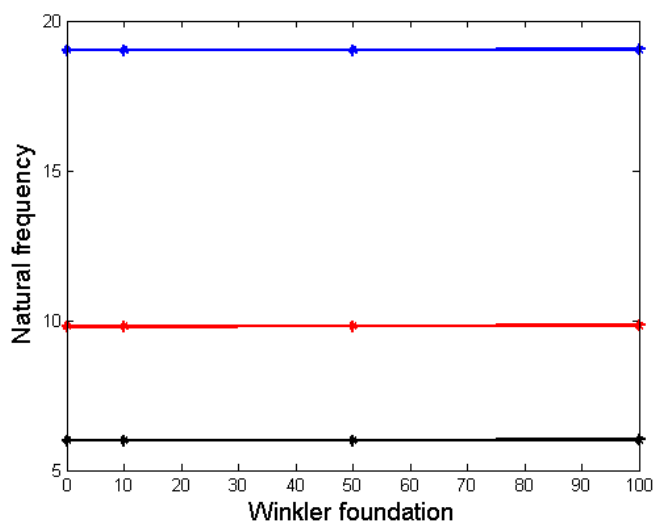
Figure 2. Influence of elastic foundation on natural frequency Clamped supported edge condition